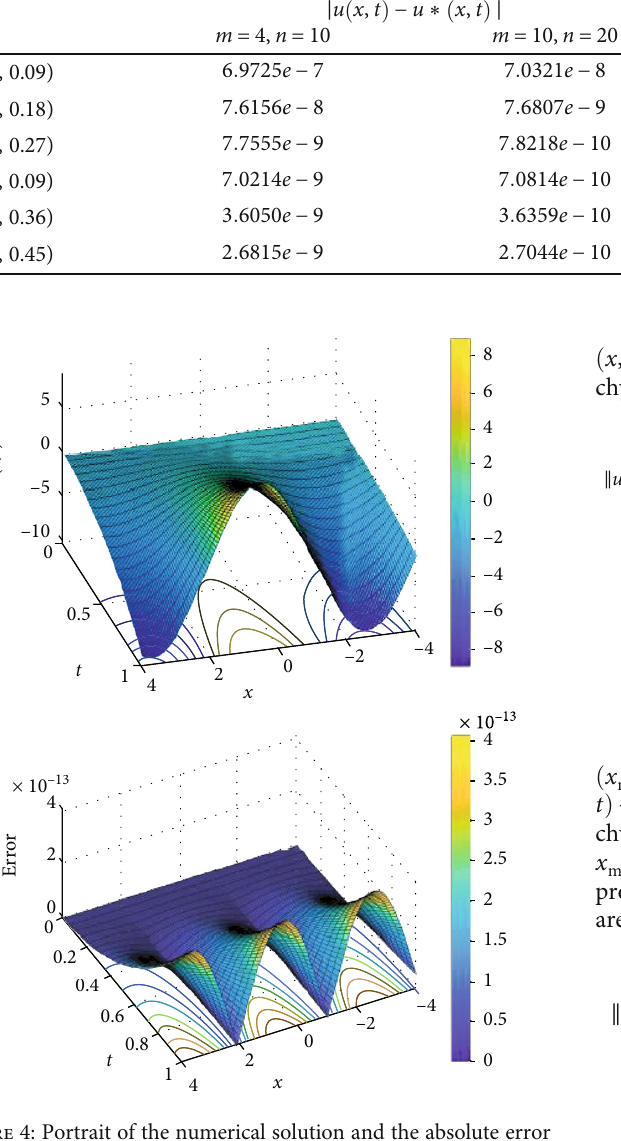
Figure 4: Portrait of the numerical solution and the absolute error for Example 9 with m = 4, n = 10